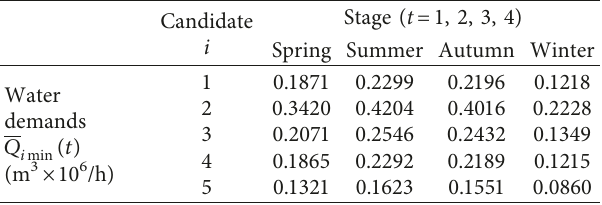
Table 7: Predicted water demands in each seasonal